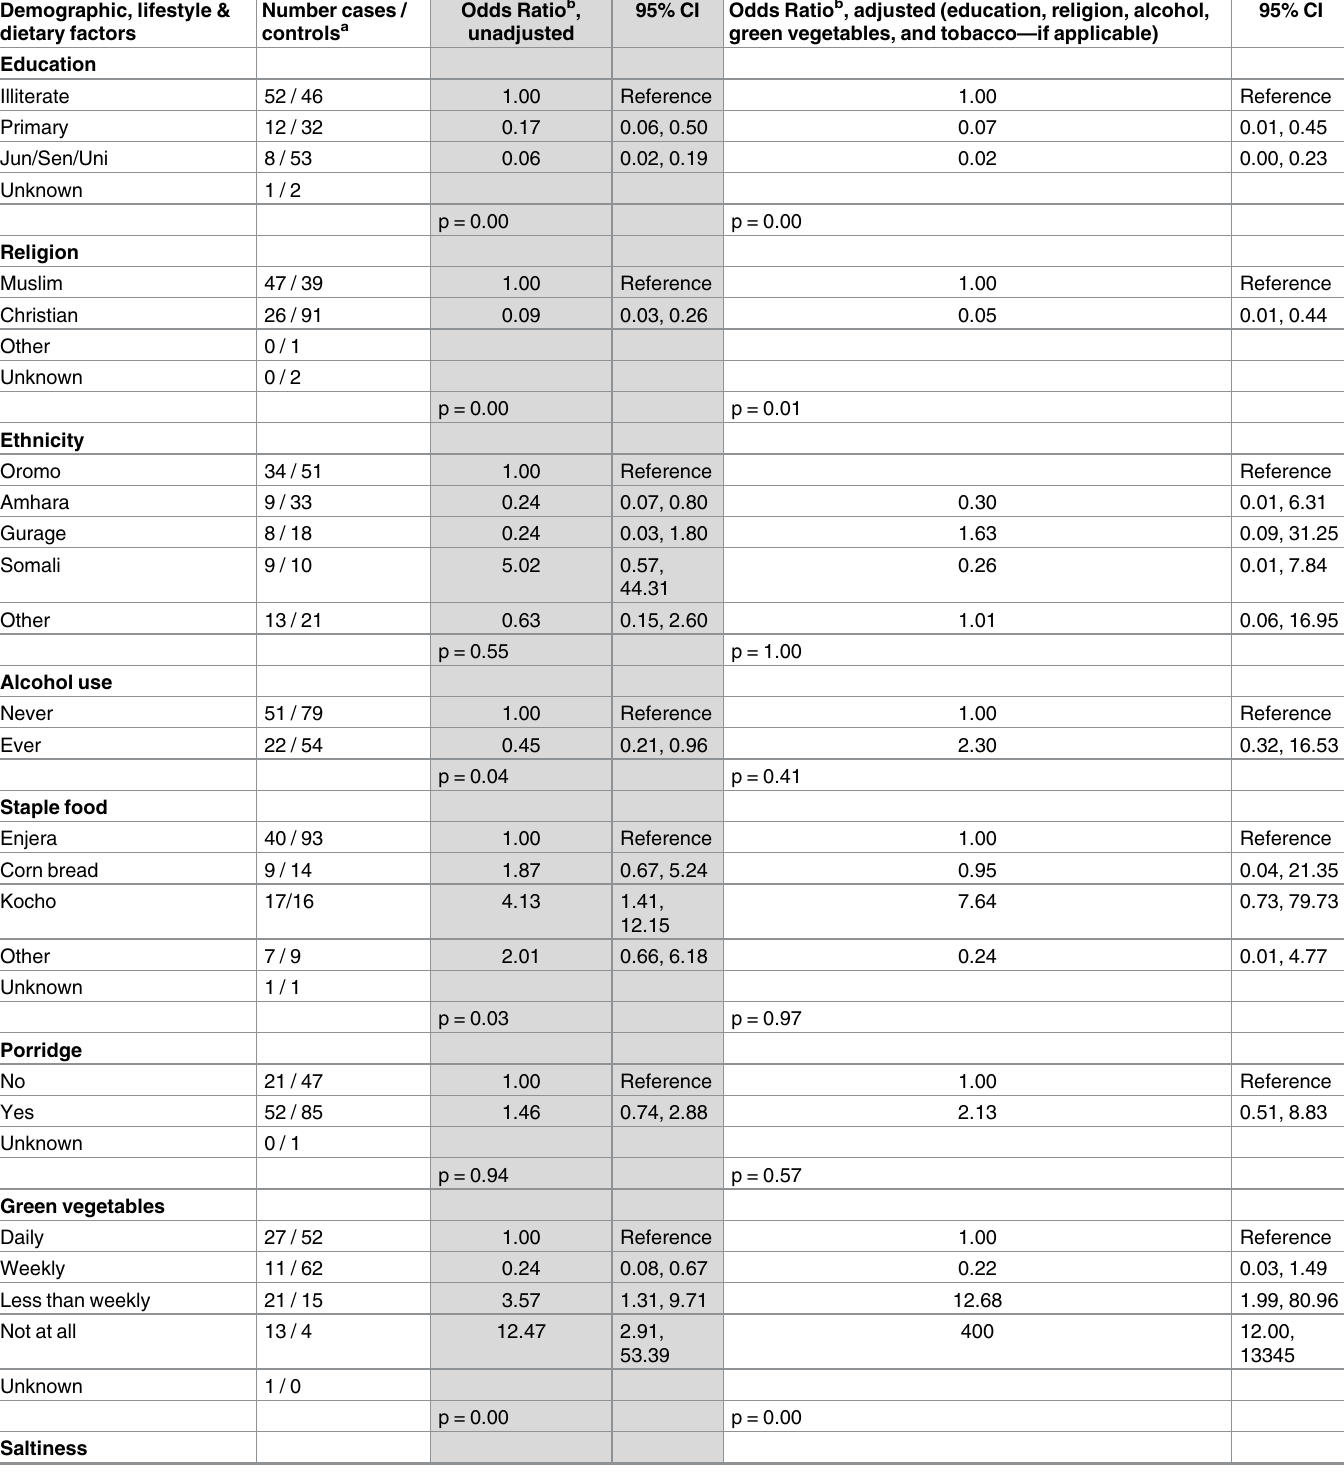
Table 3. Education level, religion, dietary habits, and risk of esophageal and gastro-esophageal junction cancerscombined in a pilot case–control study in Addis Ababa. Demographic, lifestyle & dietary